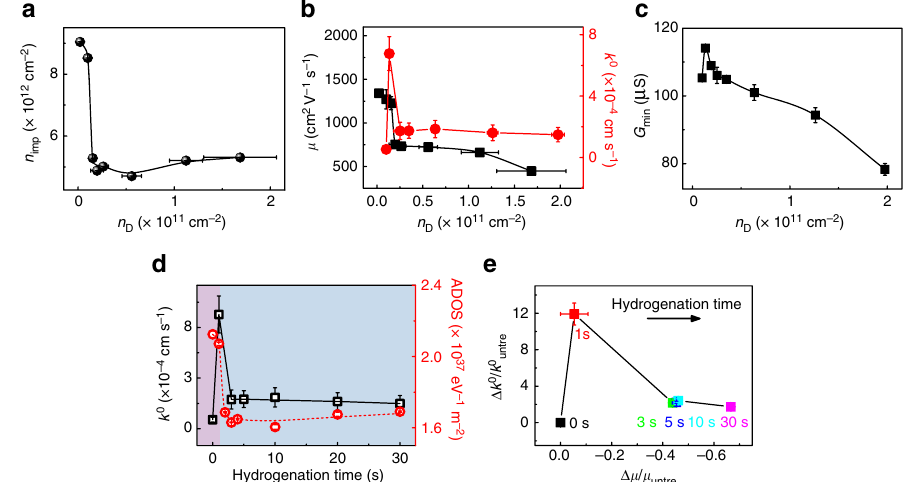
Fig. 4 Quantum and electrochemical interplays in hydrogenated graphene. a The dependence of n imp on n D . b Correlations of μ and k 0 with n D , respectively. c The minimum conductivity ( G min ) vs n D . d The correspondence between ADOS and k 0 as a function of the hydrogenation time. The purple region represents the cleaning-dominated regime and the blue region represents the regime where the chemical modi fi cation dominates. e The relative variations of Δ μ / μ untre correlating with Δ k 0 = k 0 according to the corresponding hydrogenation time. The subscript "untre" represents the untreated graphene. The untre error bars are the standard deviation of experimental